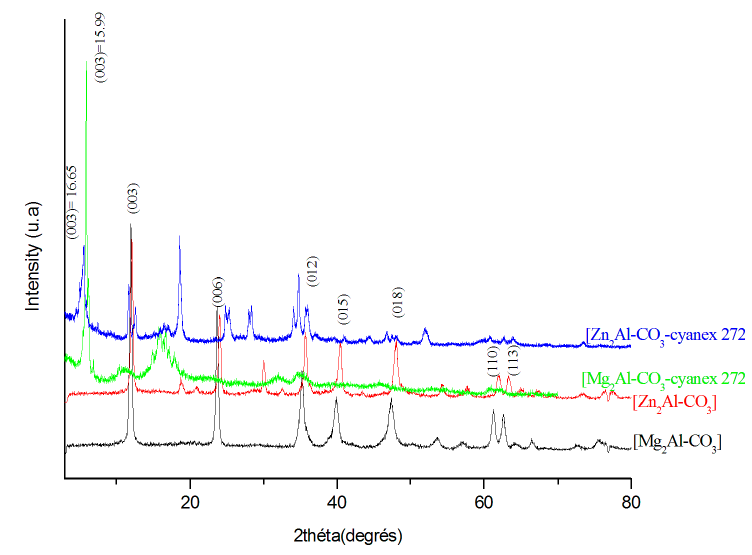
Figure 2. XRD patterns of Mg 2- Al-CO 3 , Zn 2- Al-CO 3 , Zn 2 Al-CO 3 -cyanex 272, and Mg 2 Al-CO 3 -cyanex 272.